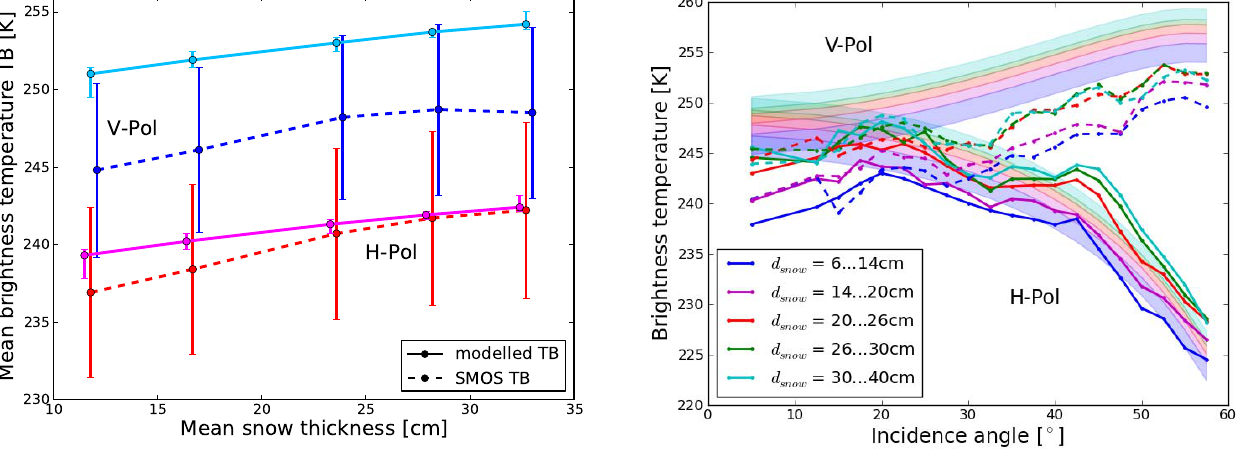
Fig. 7. Brightness temperatures as simulated and as measured by SMOS for the snow thickness classes 1–5 as given in the fig- ure legend. The shaded areas indicate the brightness temperature simulations, the lines indicate the averaged brightness temperature measurements. The solid lines indicate horizontal polarisation, the dashed lines indicate vertical